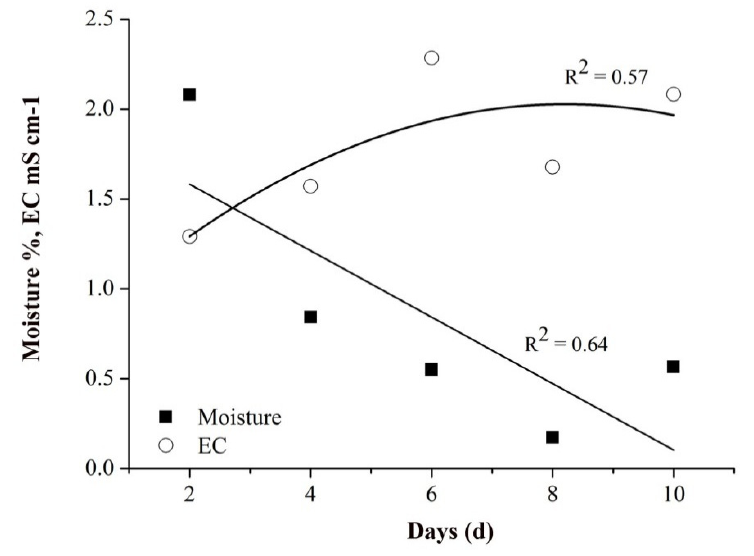
Figure 4. Functional diagram of averaged moisture and salt changes during the irrigation